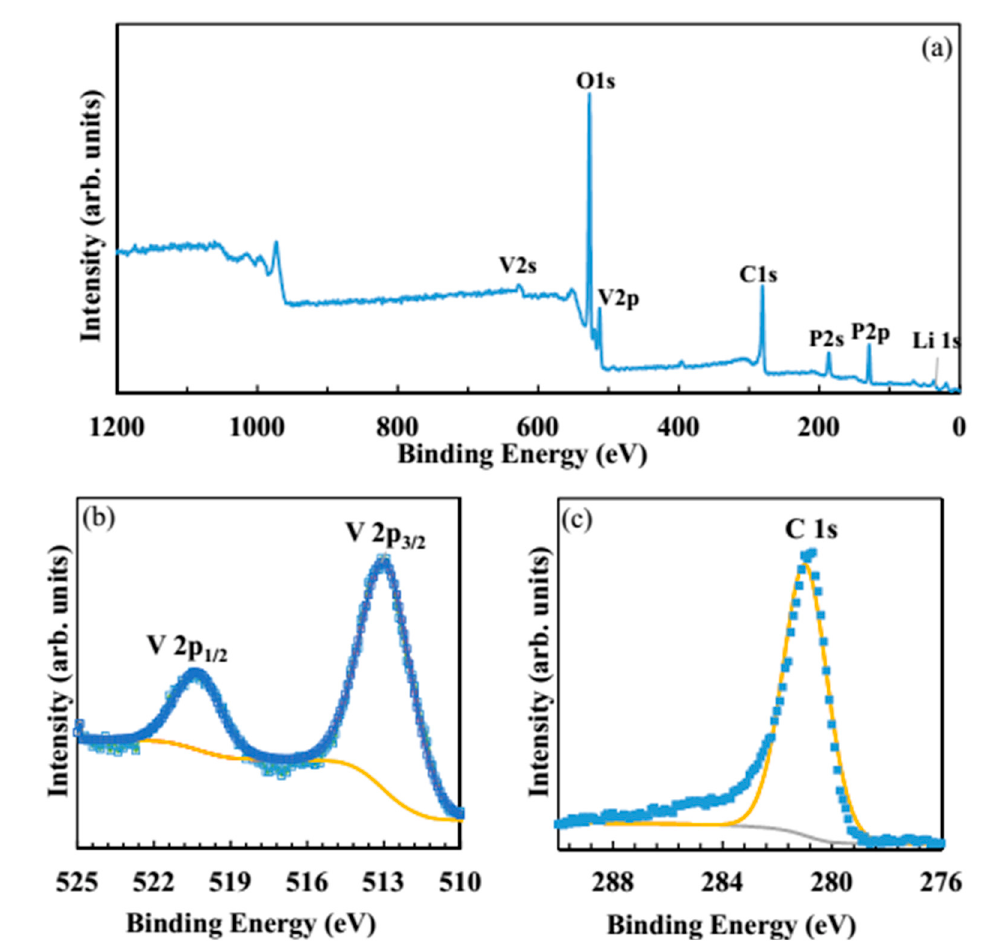
Figure 3. Wide range XPS spectrum showing ( a ), core level XPS spectra, ( b ) V2P, and ( c ) C 1s of the LVP compound prepared by the oxalic acid.